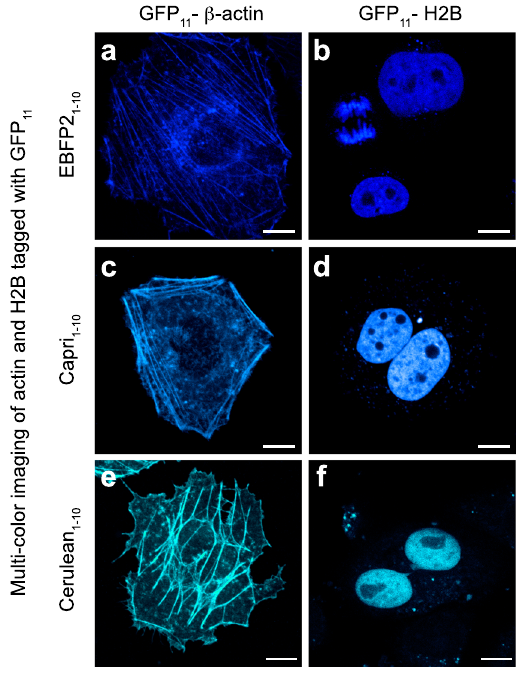
Fig. 1 Performance of BFP and CFP 1-10/11 variants in fusion constructs. a – f Confocal images of HeLa cells. Cells co-expressing EBFP2 1-10 ( a , b ), Capri 1- β -actin or histone 10 ( c , d ), and Cerulean 1-10 ( e , f ) with GFP 11 -tagged